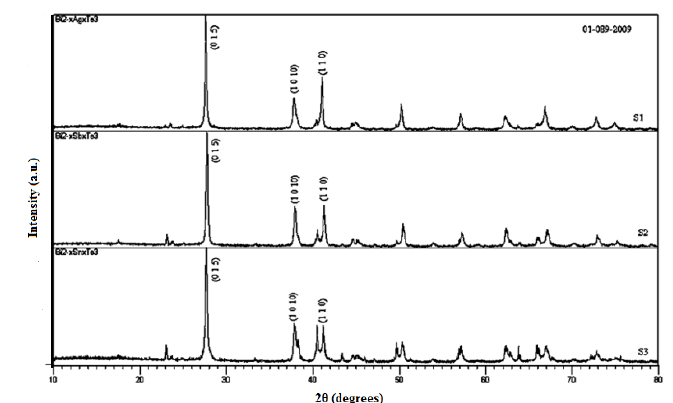
Figure 1. XRD patterns for doped Bi